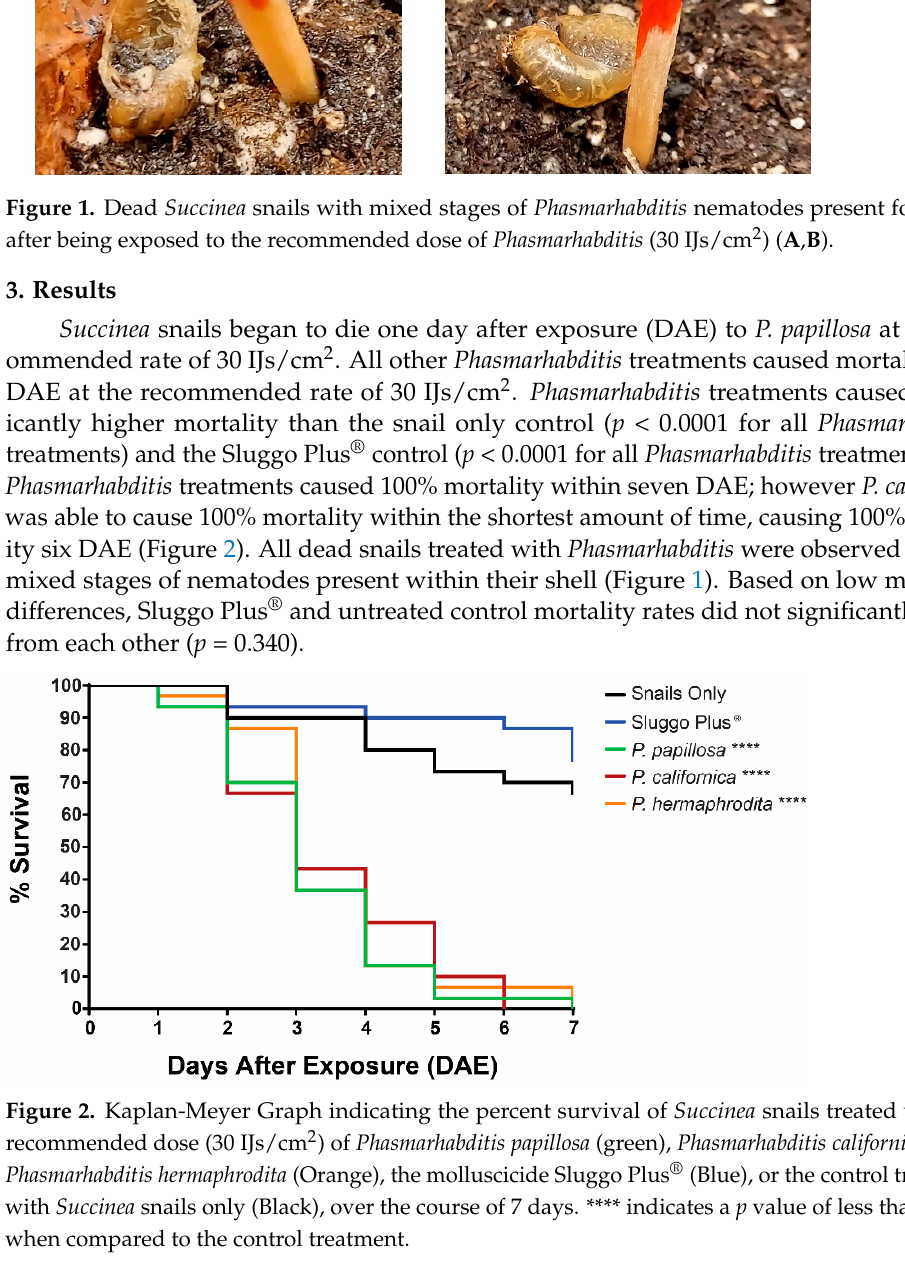
Figure 1. Dead Succinea snails with mixed stages of Phasmarhabditis nematodes present four days after being exposed to the recommended dose of Phasmarhabditis (30 IJs/cm 2 ) ( A , B ).